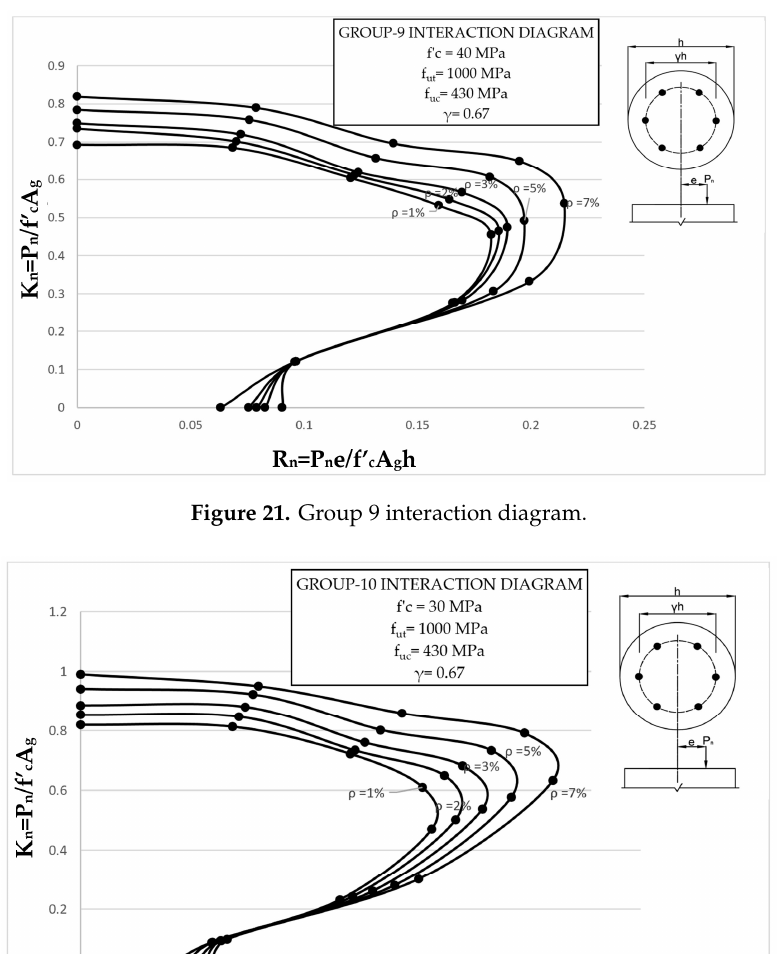
Table 6. Confined concrete strength factors and ductility indices of all concentric columns.